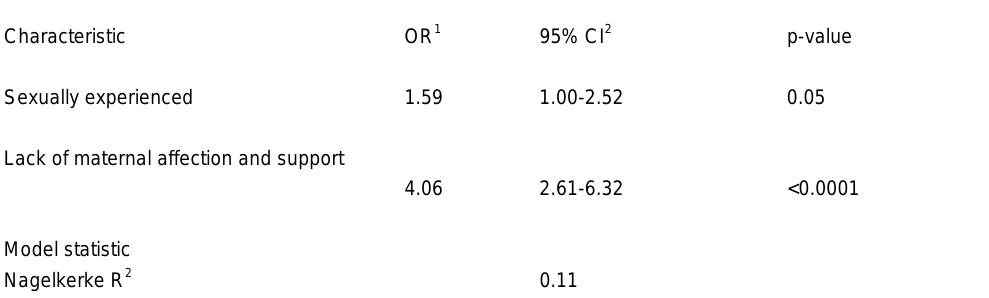
Final model predicting depressive